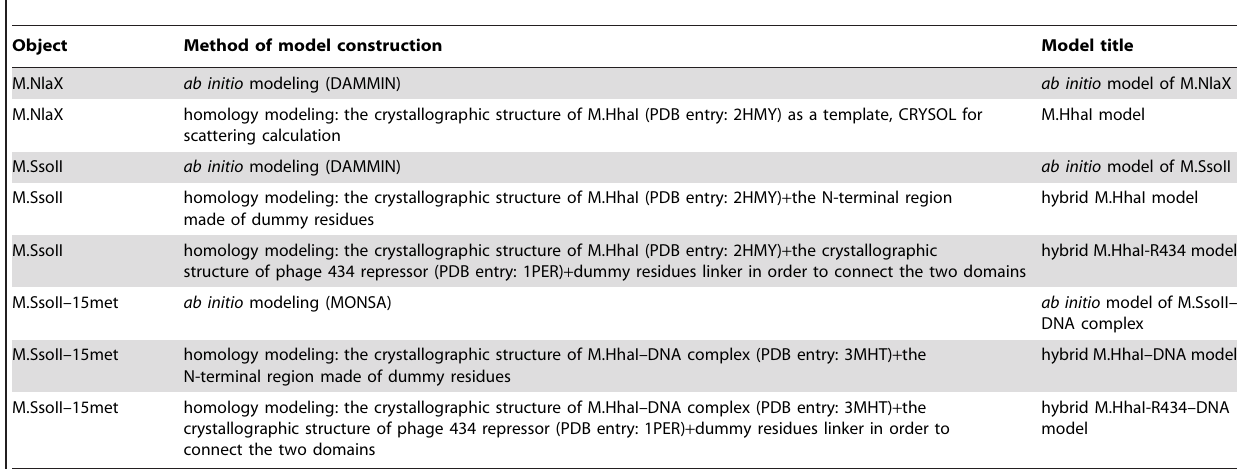
Table 1. Models of M.NlaX, M.SsoII, and M.SsoII–15met complex constructed in the present